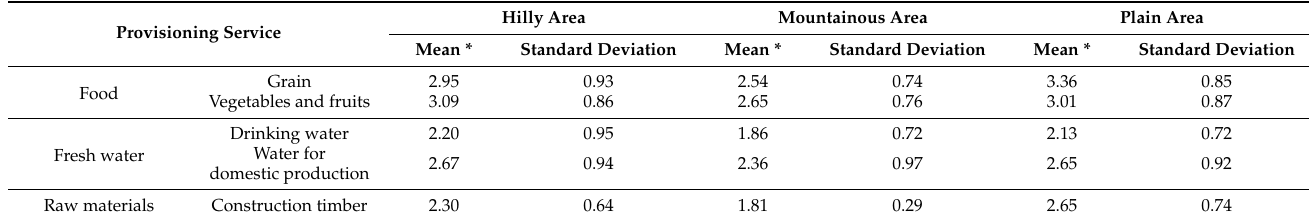
Table 5. Perception measures of provisioning service in three topographic areas.